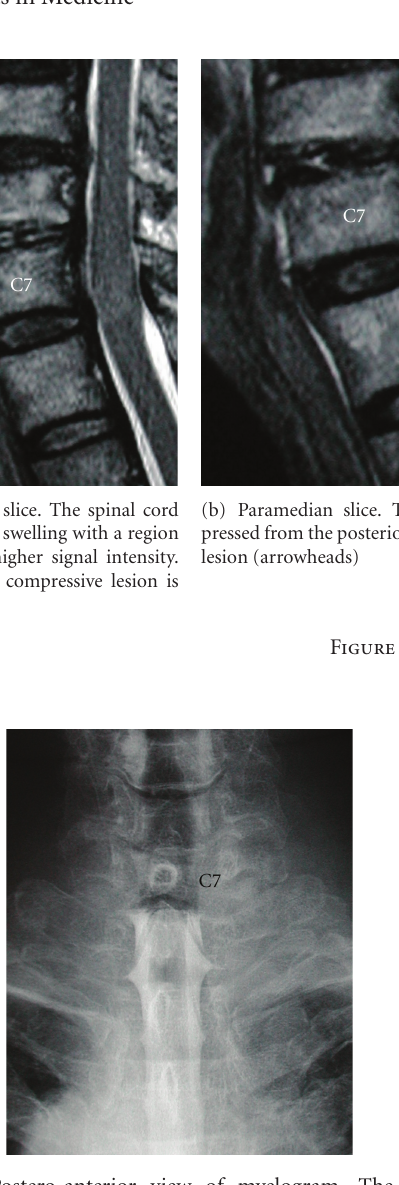
Figure 3: Postero-anterior view of myelogram. The contrast medium stops completely at C7/T1 disc level.